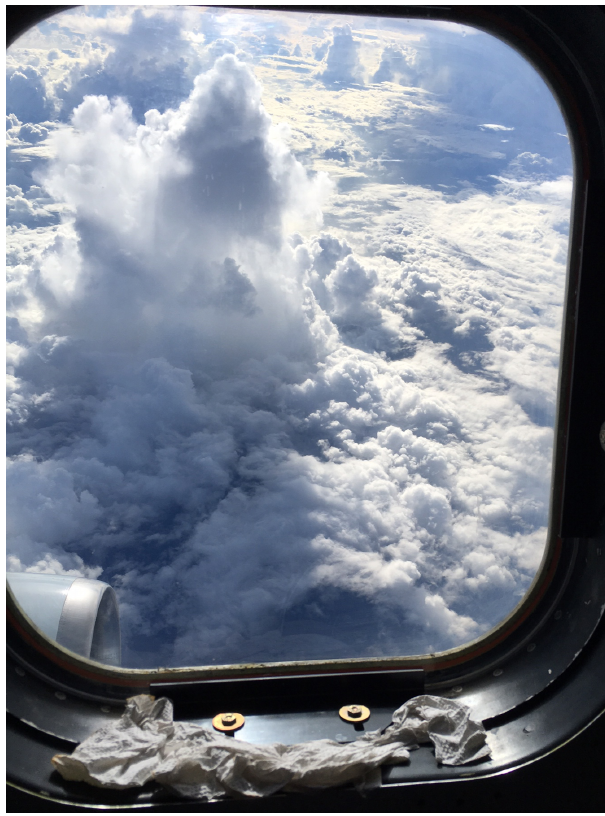
Figure 3. View of developing cumulus from the DC-8 window, near 22:00UTC on 10 June 2017, from a 10km flight